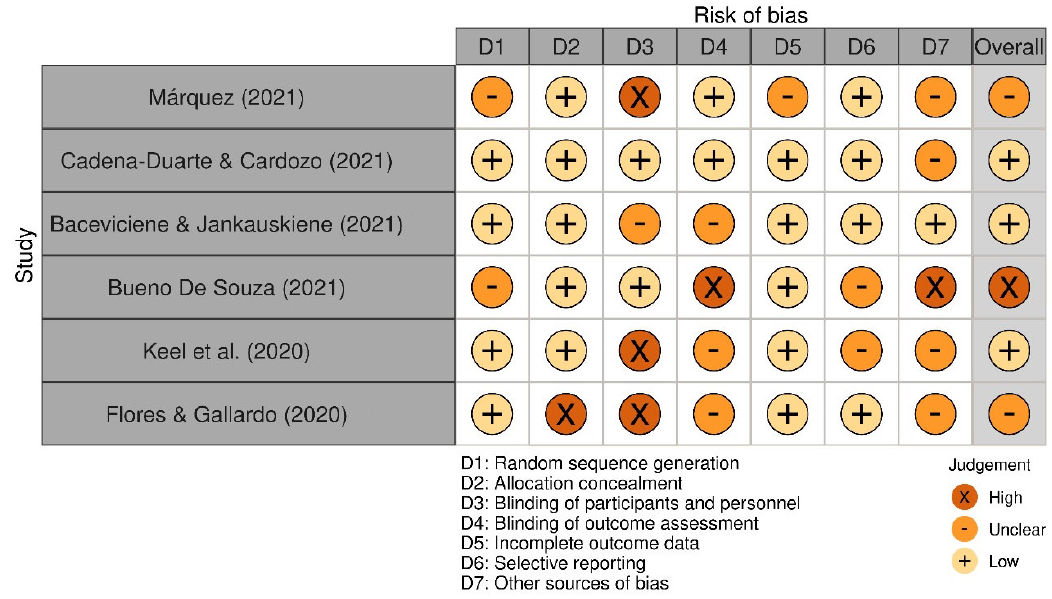
Figure 2. Bias assessment of the study included in this review. N = 6